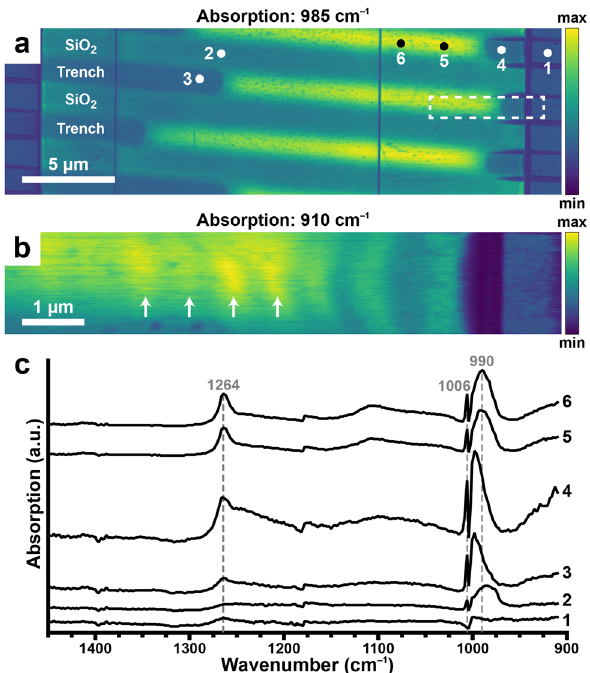
Figure 4: Photothermal induced resonance (PTIR) reveals trapped contaminants that can influence hyperbolic phonon polariton (HPhP) propagation and imaging. Absorption maps at (a) 985 cm − 1 and at (b) 910 cm − 1 , magni fi ed region from (a), of the same MoO 3 crystal shownin Figure 3 (but at a differentlocation), supported by a SiO 2 /Si grating. Relatively strong, localized absorption features (absent in topography) reveal contaminants trapped beneath the MoO 3 fl ake. (c) Absorption spectra measured at locations one to six indicated in (a) identify the contaminants as polydimethylsiloxane (PDMS), derived from sample preparation. The contaminants underneath the MoO 3 fl ake affect the HPhP propagation and change the apparent spacing between successive fringes, indicated by arrows in (b), compared with those observed in uncontaminated regions (e.g., Figure 3b and d). Topography maps acquired simultaneously with (a) and (b) are available in the Supplementary material (Figure